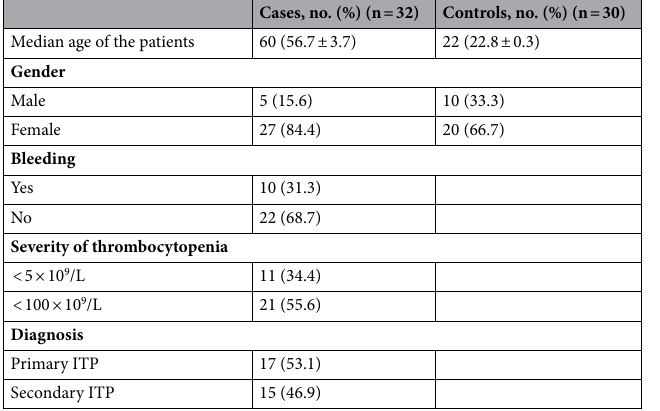
Table 1. Characteristics of patients and